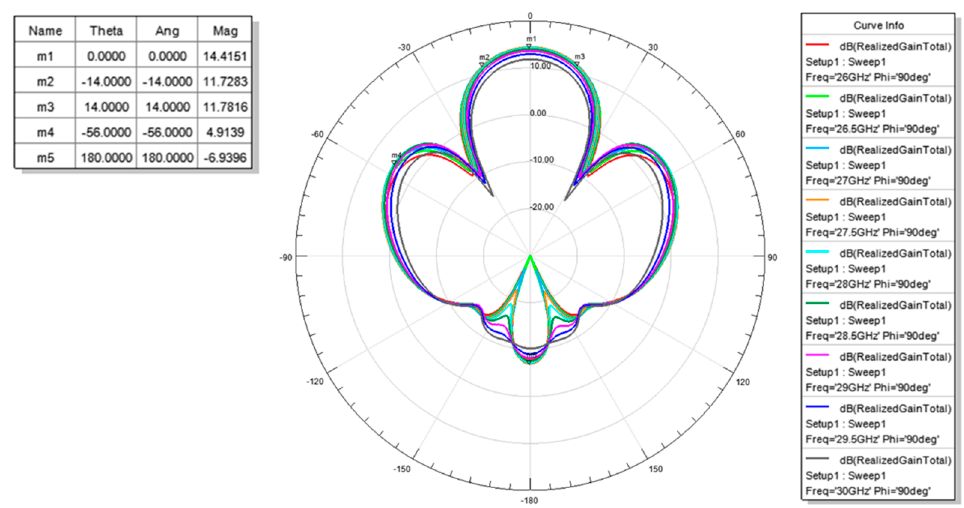
Figure 9. Radiation pattern of the simulation (Y Cut).